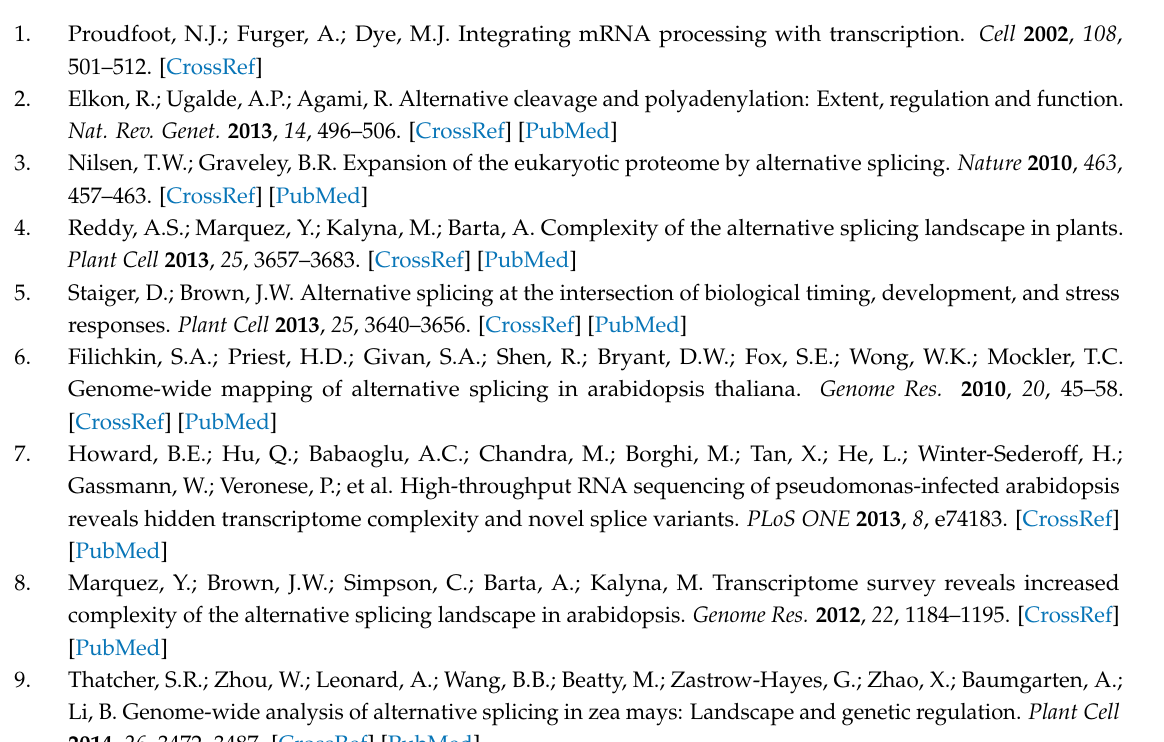
Supplementary Materials: The following are available online. Figure S1: The position of forward and reverse primers, Figure S2: Agarose electrophoresis of 3¢-RACE with cDNA of different tissue and treatments, Figure S3: Agarose electrophoresis of PCR products to confirm real-time PCR primer specificity, Table S1: Statistical data of 3¢-RACE-seq, Table S2: Summary of all detected SSs, Table S3: Summary of PASs that meet filter criteria, Table S4: Counting results of candidate PASs, Table S5: Primers used in experiments, Table S6: Clone sequencing data of 10 canonical SSs verified by